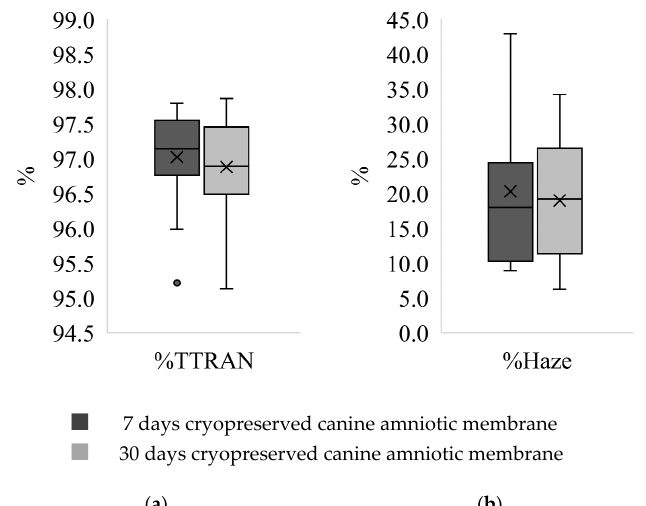
Figure 3. Series of box and whisker plots representing distribution of: ( a ) %TTRAN; ( b ) %Haze of canine amniotic mem- branes (CAM) after cryopreservation for 7 days and 30 days. The plots of CAM after 7 days of cryopreservation show skewed distribution as the mean values (X marks) are not equal to the median values (middle lines) with a few outliers (o marks), while the plots of CAM after 30 days of cryopreservation are more normally distributed. The boxes represent the interquartile range while the ends of whiskers represent the maximum and minimum values of the data.